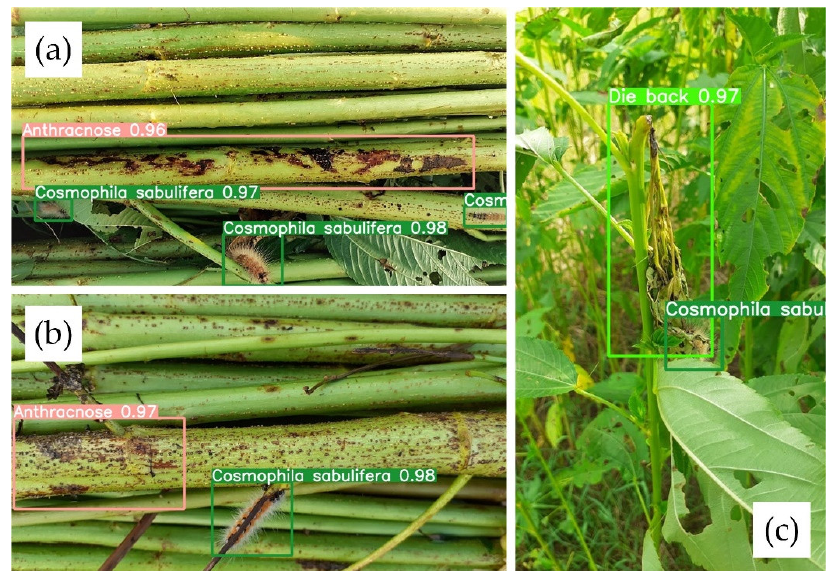
Figure 6. YOLO-JD detection on images that have multiple instances of the same disease and that have multiple classes of diseases and pests on the same image. ( a , b ) are two Jute stem images both contain Anthracnose disease and the Cosmophila sabulifera pest at the same time. ( c ) is an image contains the die back disease and the Cosmophila sabulifera pest at the same time. Table 3. YOLO-JD the results of the peeling test of the network on the Object Detection task. The best √ measures are in boldface. The “ ” sign means deployment in